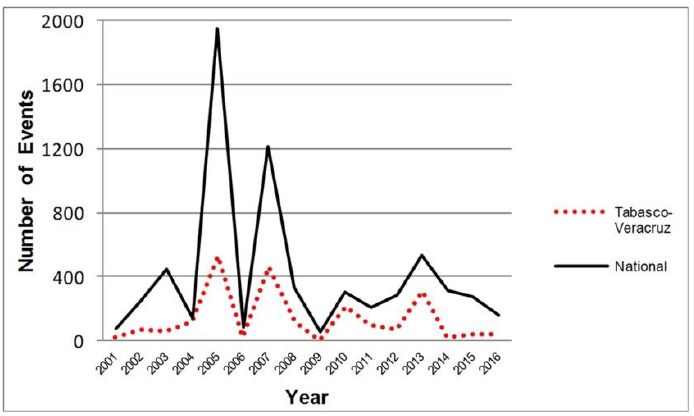
Figure 10. Number of hydrometeorological events reported in México in the period 2001–2016.